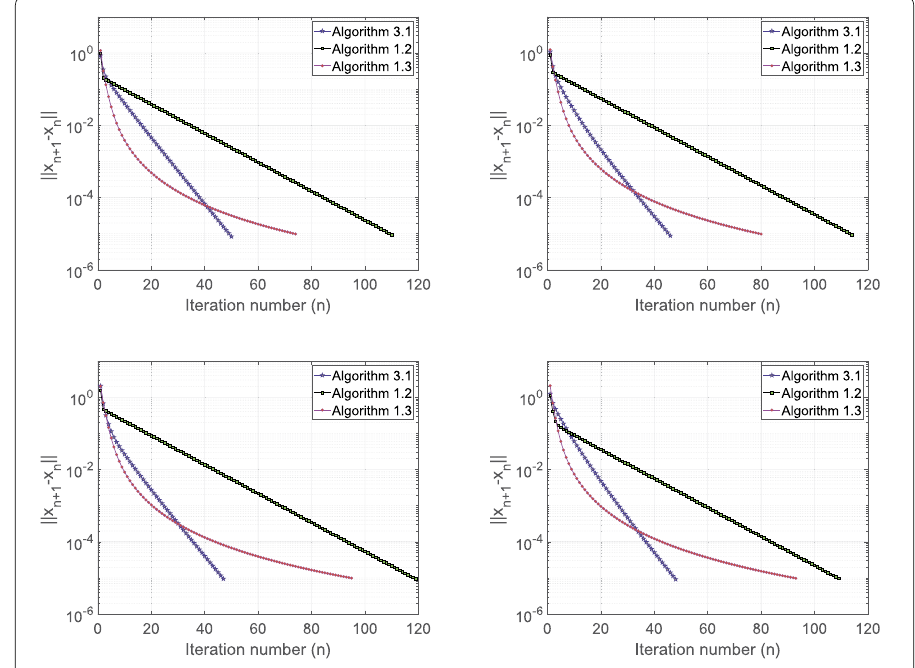
Figure 2 Example 4.1, top left: Case I; top right: Case II; bottom left: Case III; bottom right: Case IV